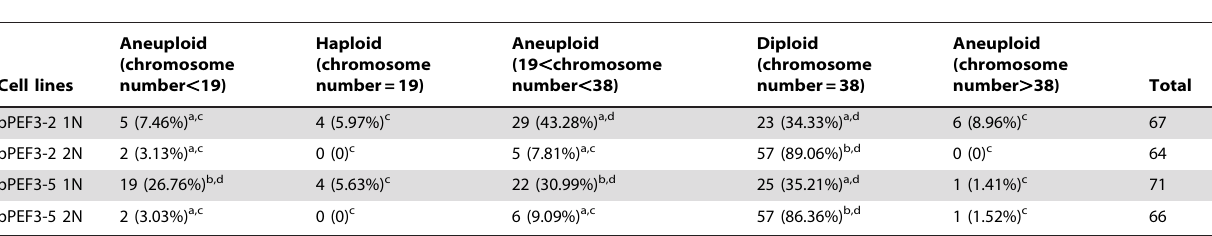
Table 4. The karyotype distribution of porcine parthenogenetic fetal fibroblasts after sorting.